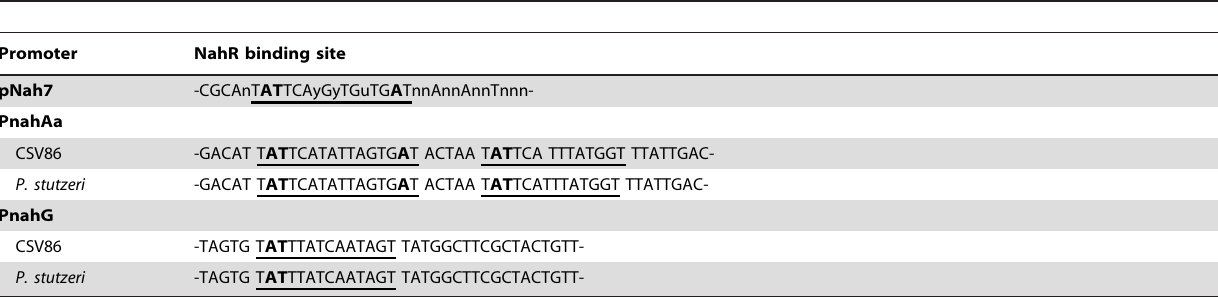
Table 2. Consensus sequence of nahR binding site in nahAa and nahG gene obtained from P. putida plasmid NAH7.